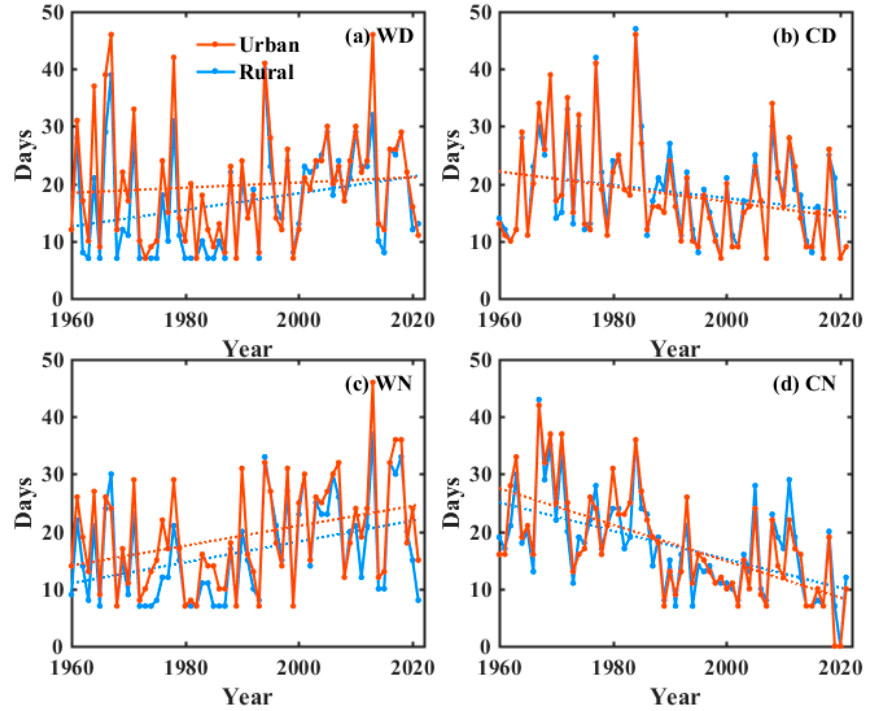
Figure 9. Changes in relative extreme temperature indices in urban/rural areas in Nanjing during 1960–2021: ( a ) warm days; ( b ) cold days; ( c ) warm nights; ( d ) cold nights.